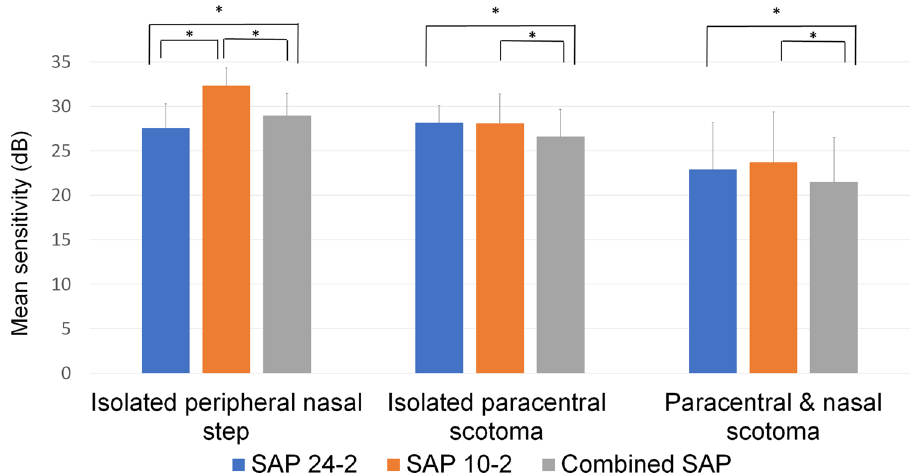
Figure 3. Global MS of the VF test. In the peripheral nasal step group, the MS was decreased in the 24-2 VF test and the combined VF test when compared with in the 10-2 VF test (both P < 0.001). In the isolated paracentral scotoma group and the paracentral and nasal scotoma group, the MS was the smallest in correlation with the combined VF test among the three VF tests (all P < 0.005).